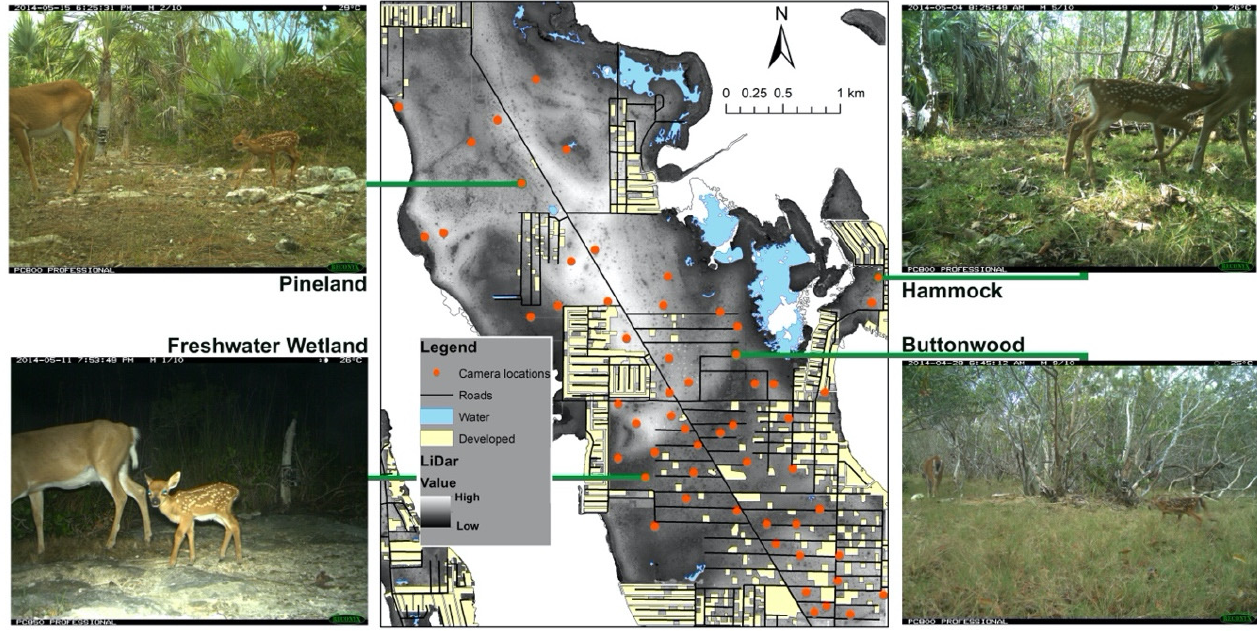
Figure 2. Camera trap locations, habitat elevation (LiDar), developed areas, and representative photos of habitats from surveys of individually identifiable key deer ( Odocoileus virginianus clavium ) fawns and unidentifiable adult does detected in the National Key Deer Refuge, Big Pine Key, Florida, 1 May–2 June 2014.